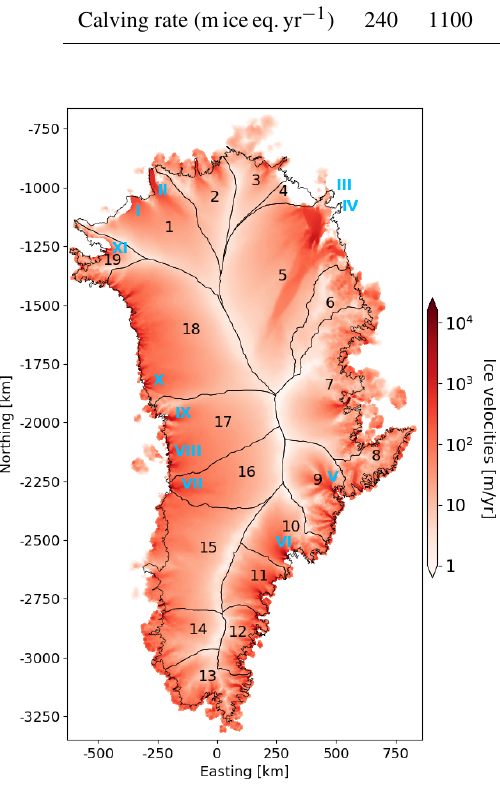
Figure 3. Steady-state ice velocities at the end of the second phase of the GrIS spin-up. Arabic numerals (black) show the individual basins. Roman numerals (cyan) show the outlet glaciers where ice front movement is simulated and ocean melt